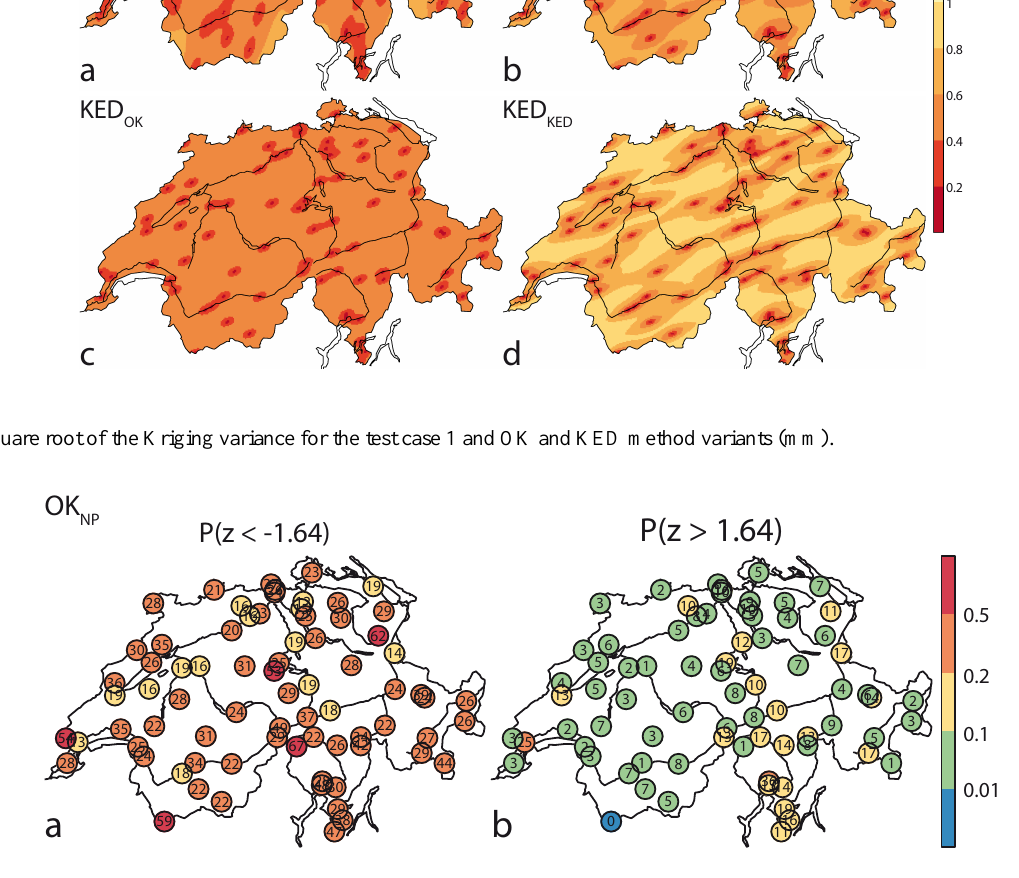
Fig. 14. Assessment of the Kriging variance for the OK np method. At each gauge location the color and numbers (%) show (a) the relative frequency of underestimating the precipitation by 1.64 standard deviations or more, (b) the relative frequency of overestimating the precipitation by 1.64 standard deviations or more. The analysis includes all gauge observations ≥ 0.5 mm .